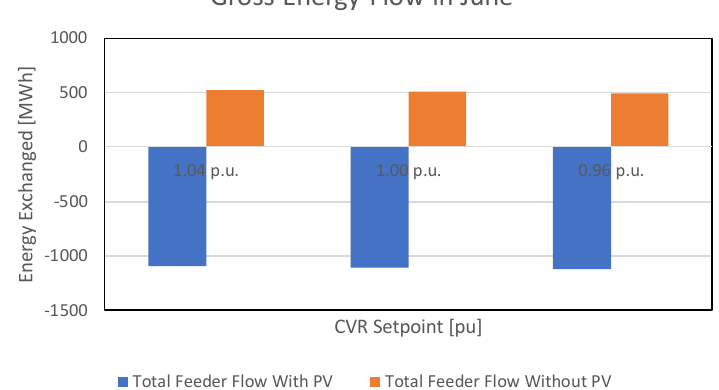
Figure 16. Energy transacted in the billing cycle comparing the case of large-scale PV penetration and that without (masked load only).